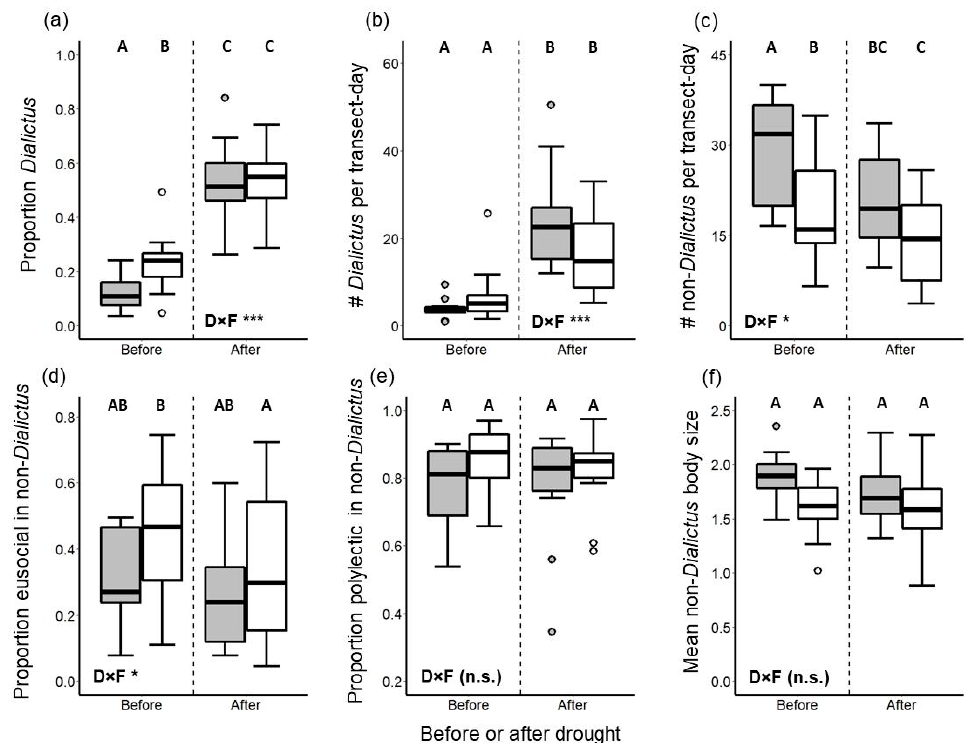
Figure 4. Comparisons of Dialictus and non- Dialictus bee assemblages in scrub reserve plots (gray boxes) and scrub fragment plots (white boxes) before (2011 and 2012) and after (2015 and 2016) a severe drought event in 2014. Panels ( a – f ) depict different characteristics of bee assemblages; in panel ( f ), the metric used for bee body size is mm intertegular distance. Boxplots and denotations of the statistical significance of the interaction between drought status and fragmentation status (“D×F”) are as in Figure 3.